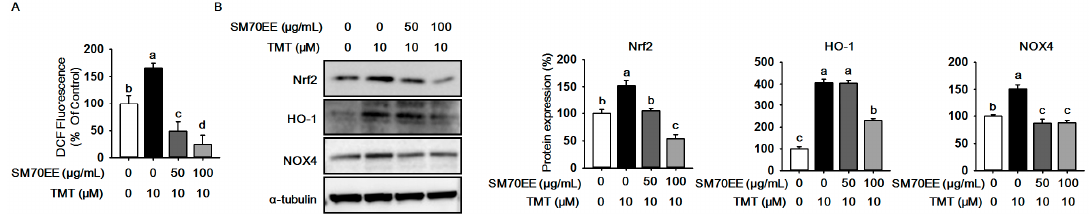
Figure 2. SM70EE inhibits ROS production in TMT-induced neurotoxicity in HT-22 cells. ( A ) HT-22 cells were pretreated 50 and 100 μ g/mL SM70EE for 4 h before treatment with 10 μ M TMT for 24 h. ROS production was measured by a DCF-DA assay. The experiments were performed in hexa-plicate; ( B ) HT-22 cells were pre-treated 50 and 100 μ g/mL SM70EE for 4 h before treatment with 10 μ M TMT for 24 h. Cells lysates were subjected to western blot analysis to measure the levels of HO-1, NOX4, and SOD2. The protein expression level was quantified using Image J software and normalized against α -tubulin and control. Results were analyzed by one-way ANOVA and Duncan’s multiple range tests. The p -value in the multiple comparison results (e.g., a, b, c, and d) indicate significant differences among the groups ( p < 0.05).